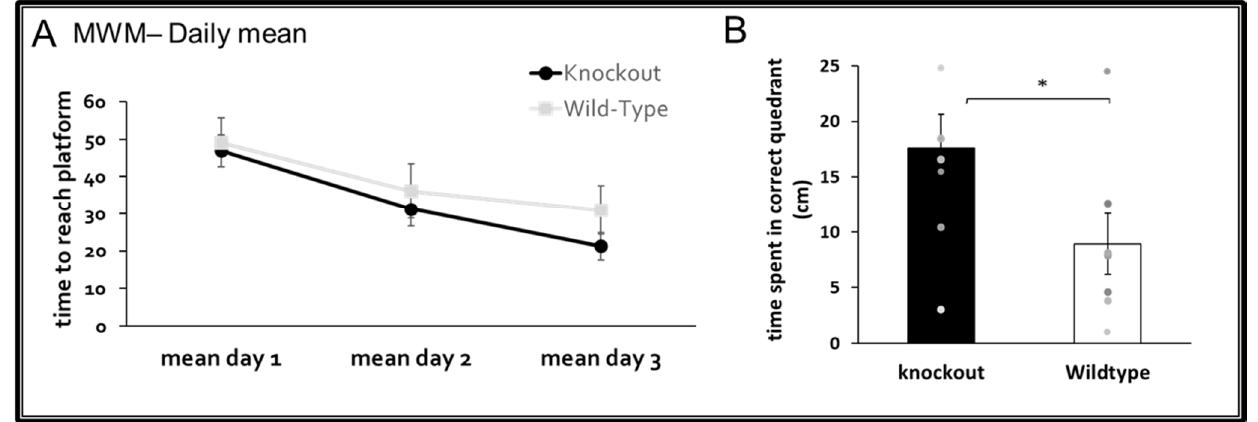
Figure 5 . The effect of CD24 knockout on long-term spatial memory. Abolition of CD24 improved long-term memory in the radial water maze at 6 months. A significant difference was found at the probe test (B, p<0.05), while a trend for better spatial learning was found at the final learning stage (A). n = 8 mice per group.